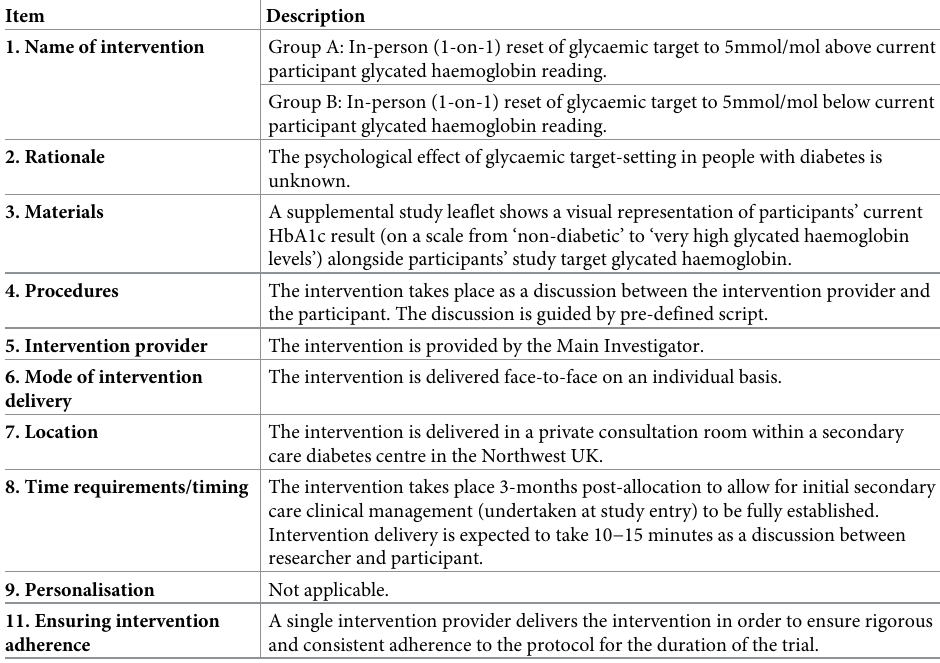
Table 1. Study intervention described using the TIDieR